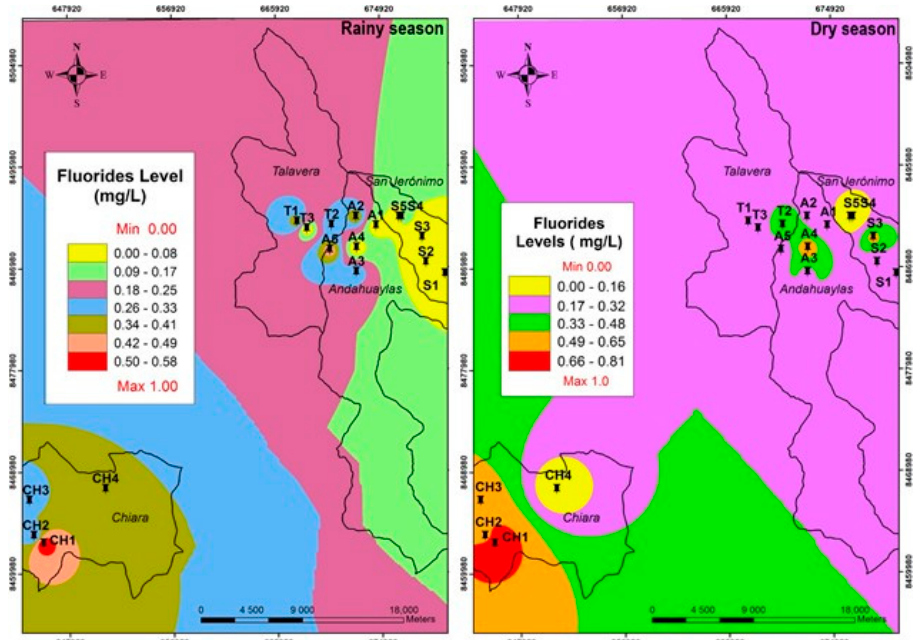
Figure 6. Variation of water fluoride level in the sampling areas.